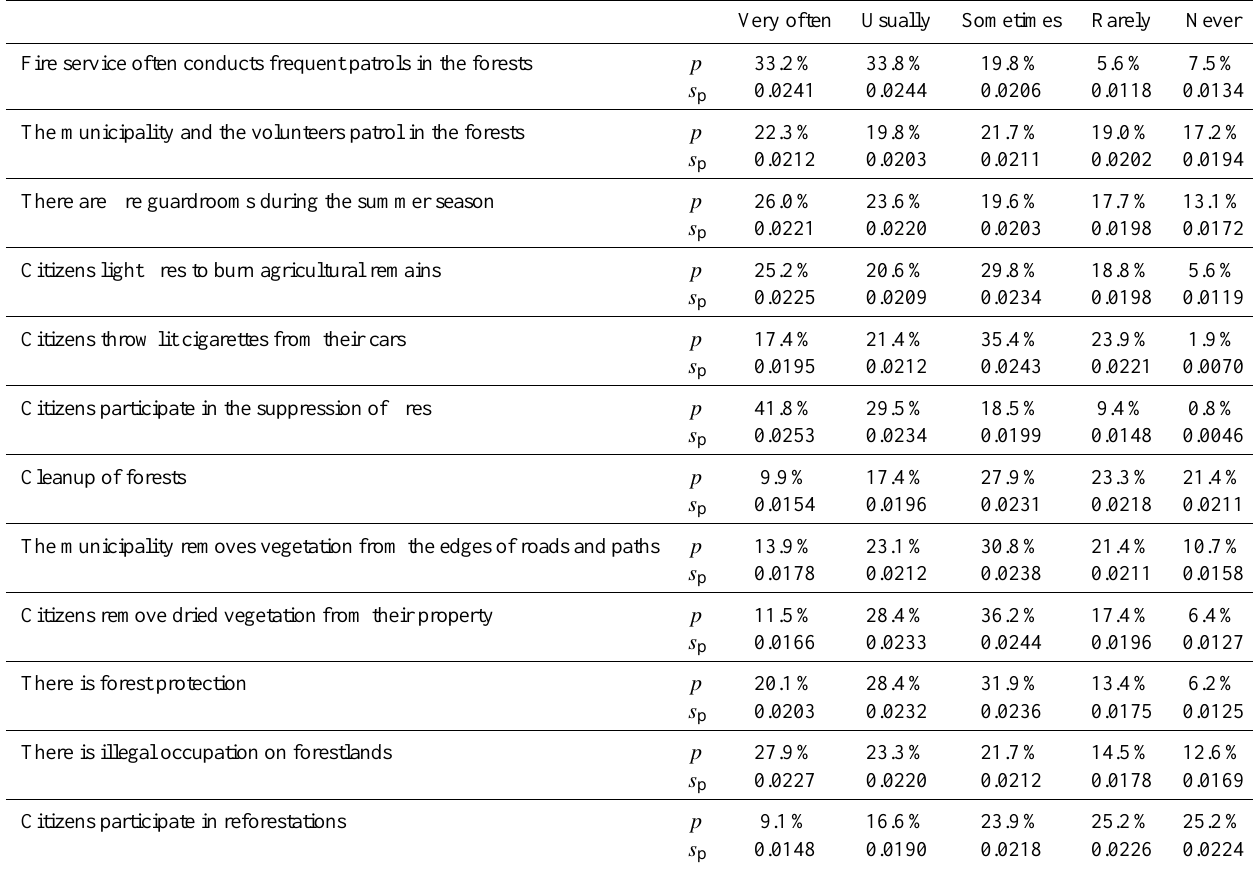
Table 7. Residents’ opinions about the activities that take place in the Sporades islands regarding the prevention of forest fires. Very often Usually Sometimes